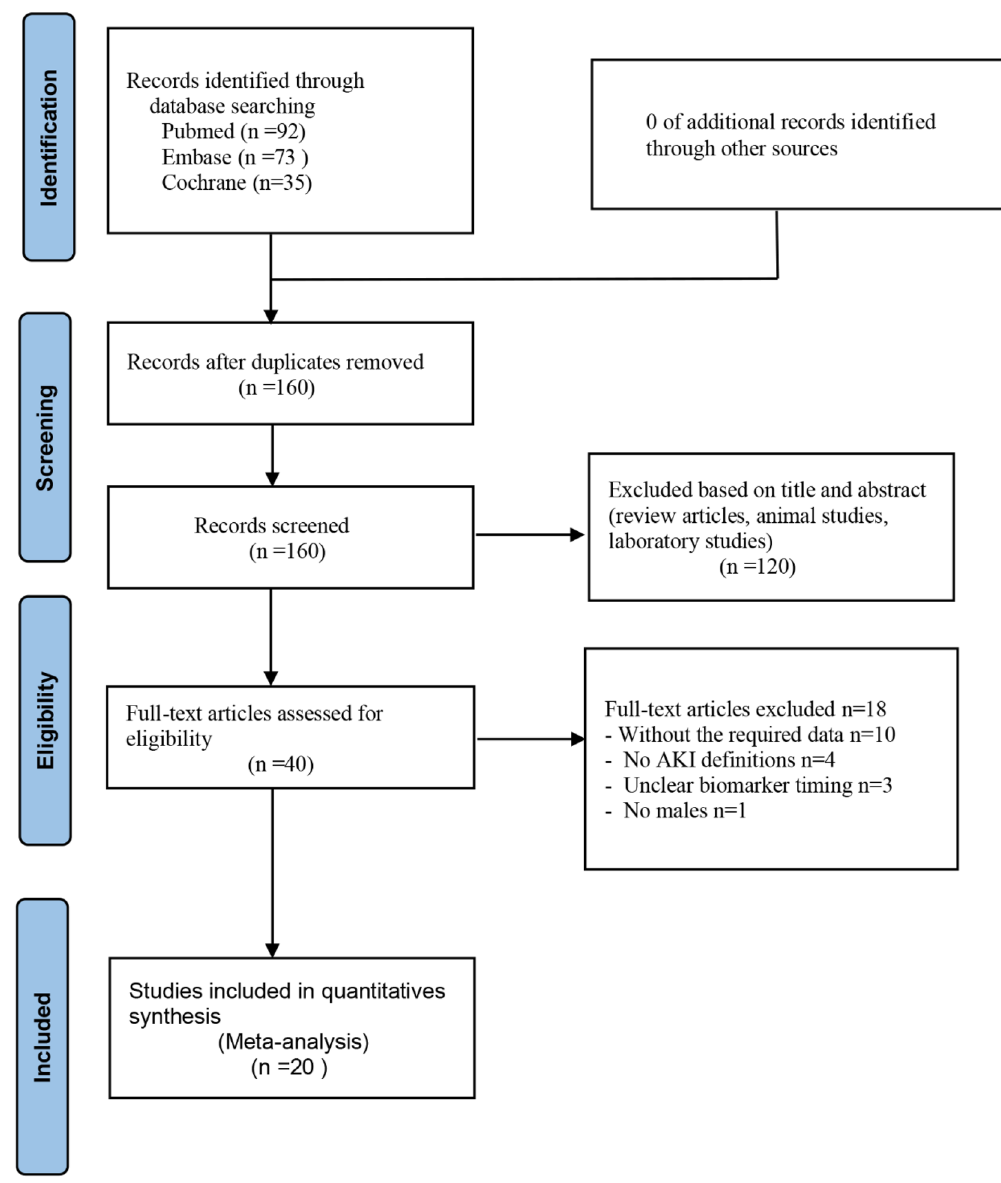
Figure 1. Flow chart of study